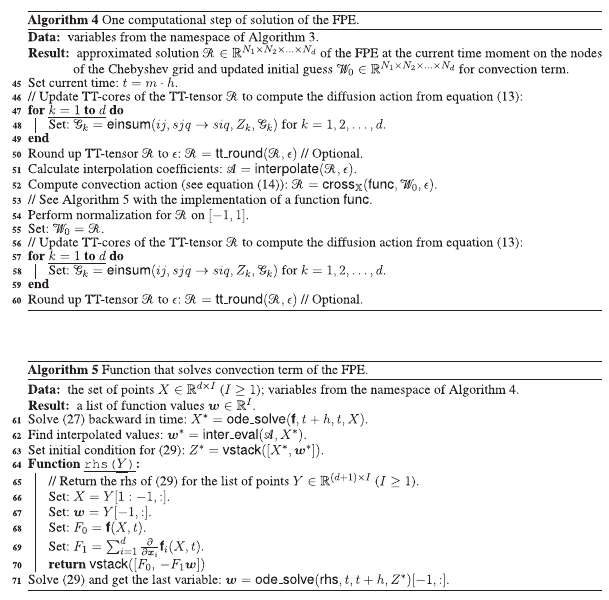
Algorithm 2 that constructs interpolation coef fi cients and function inter _ eval that evaluates interpolation result at given points according to the formula eq. 35